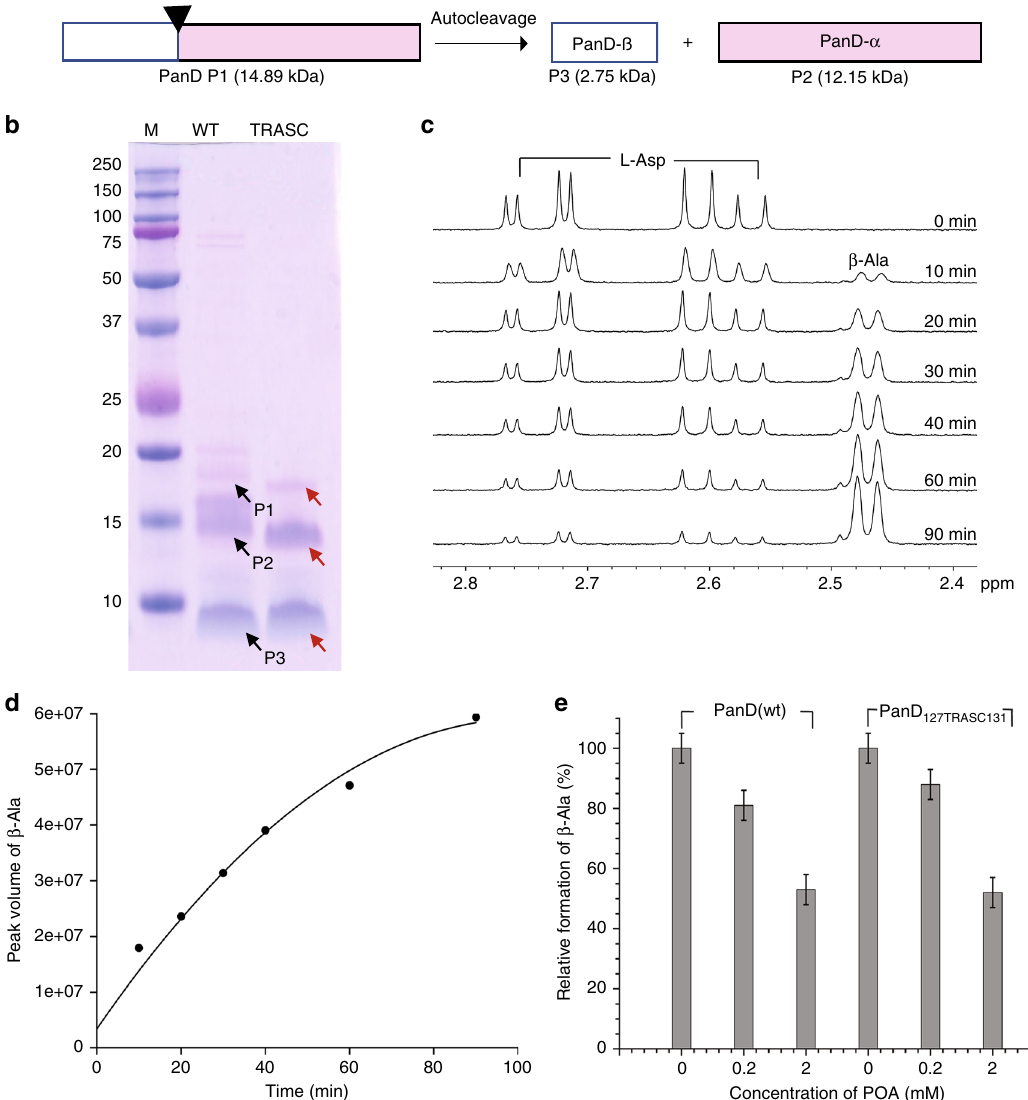
Fig. 1 Veri fi cation of puri fi ed recombinant PanD proteins and effect of POA on PanD enzymatic activity. a Schematic depicting the autocleavage of PanD at the Gly24-Ser25 position to yield enzymatically active enzyme comprising of a C-terminal (PanD- α ) and an N-terminal fragment (PanD- β ) 15 . b Twelve percent SDS-PAGE of puri fi ed, N-terminal His-tagged recombinant proteins PanD WT (WT) and C-terminal truncated, non-POA binding PanD 127TRASC131 (TRASC). To determine the identity of the protein bands, the bands corresponding to P1, P2, and P3 were cut out, in-gel digested with trypsin and subjected to LC – MS analysis. PanD is synthesized as a proenzyme and rapidly autocatalytically cleaved at its N-terminus, resulting in a small N- terminal fragment (P3, expected size including His Tag for WT and TRASC: 3.75 kDa) and a larger C-terminal polypeptide (P2, expected size for WT: 12.15 kDa and TRASC: 11.4 kDa). Traces of uncleaved proenzyme are indicated (P1, expected size including His Tag for WT: 15.9 kDa and TRASC: 15.15 kDa). Black and red arrows indicate the corresponding protein bands of wild-type and truncated PanD, respectively. c , d Time-dependent conversion of L- Aspartate (2 mM) to β -Alanine ( β -Ala) as determined by 1 H NMR after addition of 10 µ M Mtb PanD WT in D 2 O at 298 K on a Bruker Avance 400MHz spectrometer. Shown are ( c ) representative 1 H NMR spectra and ( d ) a plot of time-dependent β -Alanine formation at different incubation times by measuring the peak volume of converted L-Asp to β -Ala. At t = 40 min, ~50% conversion of L-aspartate to β -Alanine was observed as determined by integration of peak values. Thus, 40 min was chosen as a reference point within the linear range of PanD enzyme kinetics for subsequent enzyme assays. e Effect of POA on the formation of β -Ala by recombinant PanD WT and POA-resistant PanD 127TRASC131 proteins, respectively, as determined by 1 H NMR. The plot shows the results of a representative experiment. NMR spectra for e are shown in Supplementary Fig. 1. Both recombinant proteins were puri fi ed as described 4 . The NMR experiments were repeated twice independently, yielding the same results. The results from a representative experiment are shown. Error bars were de fi ned as 5% standard deviations. Source data are provided as a Source Data fi le. The cleaved form of the wild-type protein P2 migrates as a doublet with similar staining intensity. The reason for this behavior remains to be determined. LC – MS analysis of the doublet band suggests that both sub-bands present P2 (Supplementary Data 1_P123seq). The P2 doublet is speci fi c to recombinant wild-type protein and is not observed in the mutant PanD 127TRASC131 or in whole cell extracts (see Fig. 4, western blot analyses). The SDS-PAGE analyses show that the recombinant PanD protein preparations used for in vitro analyses in the current study presented largely the cleaved, active form of the